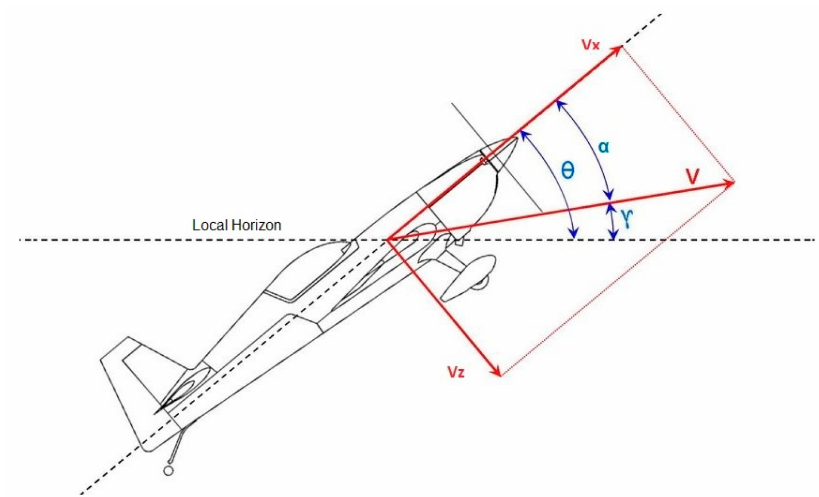
Figure 1. Fundamental angles of the longitudinal movement of an aircraft (figure uploaded by Baron Johnson